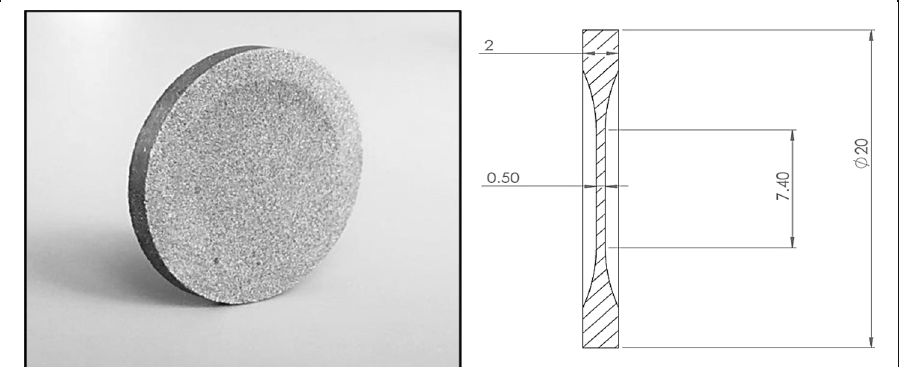
Fig. 1 Photograph of SLM disk and schematic diagram of disk